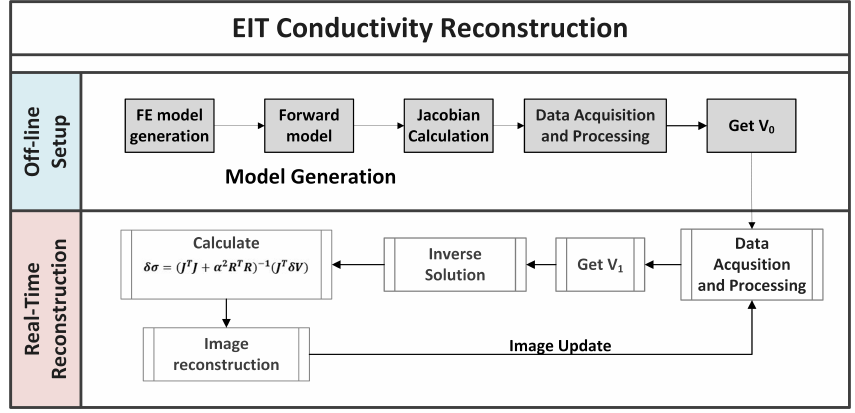
Figure 1. Flow chart of Electrical Impedance Tomography (EIT) image reconstruction. The grey shaded boxes show the calculations done in the offline setup of the system. Then, the second set of potentials V 1 is updated online and an image showing the conductivity changes inside the sensor is